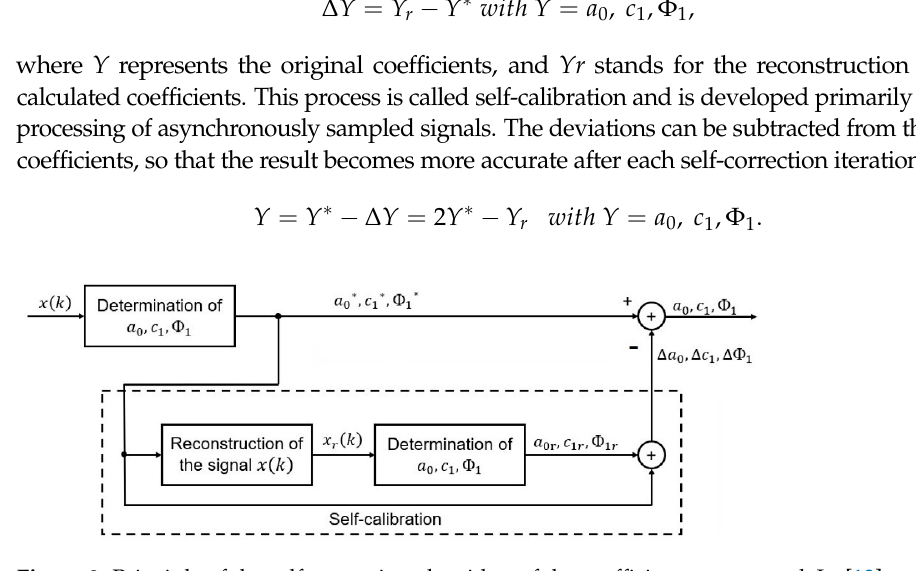
Figure 3. Principle of the self-correction algorithm of the coefficients a 0 , c 1 ,and Φ 1